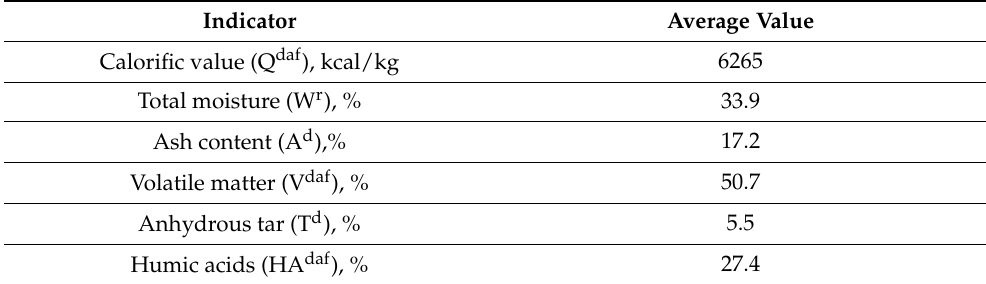
Table 2. Quality indicators of lignite in the Nizhne-Kas area [41].